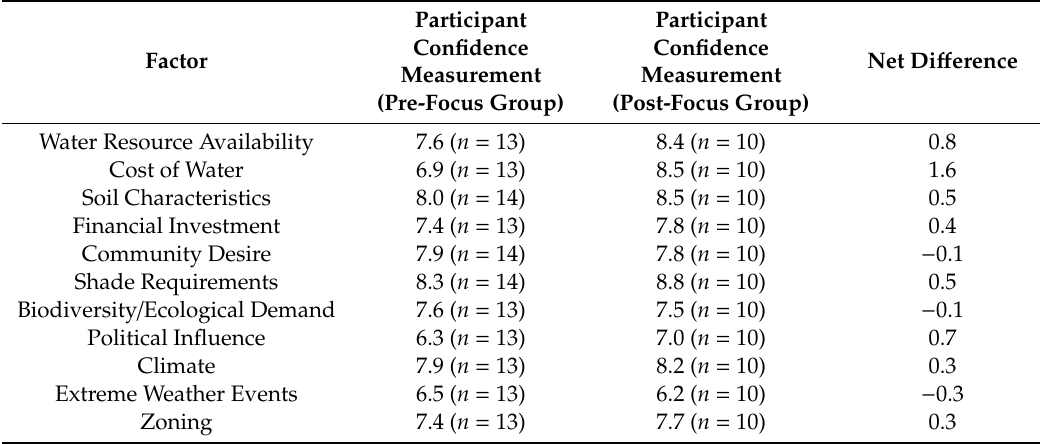
Table 4. Focus group participation factor scoring.